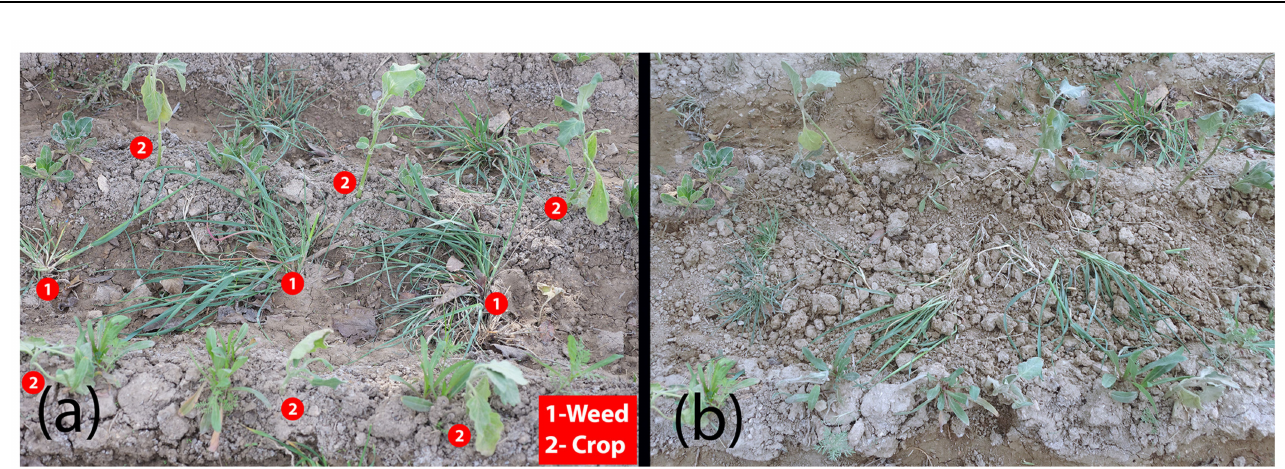
Figure 15. A sample area: ( a ) before weeding, and ( b ) after